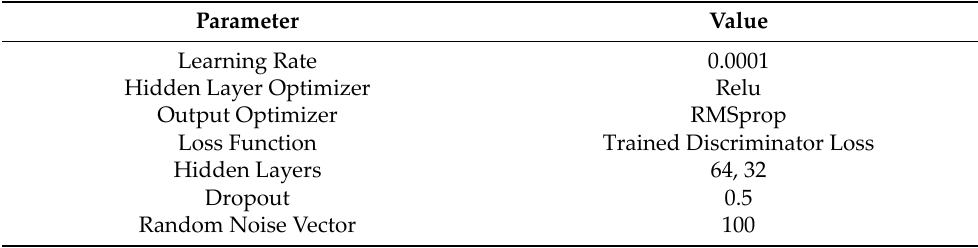
Table 6. GAN Generator Neural Network Hyperparameter Settings.